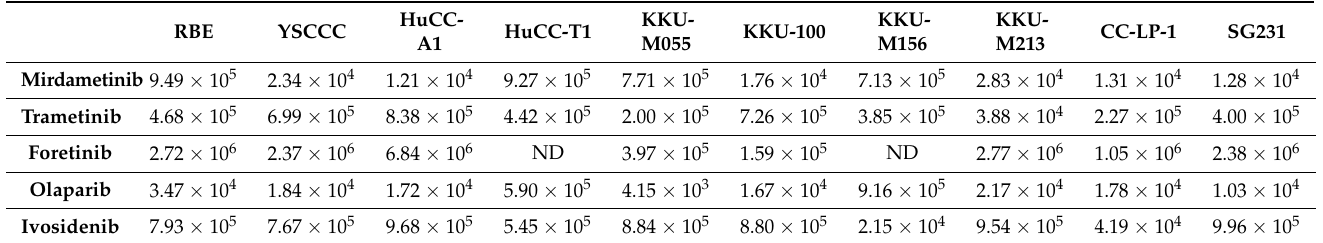
Table 4. IC 50 -values [M] of 10 evaluable CCA cell lines. ND, not